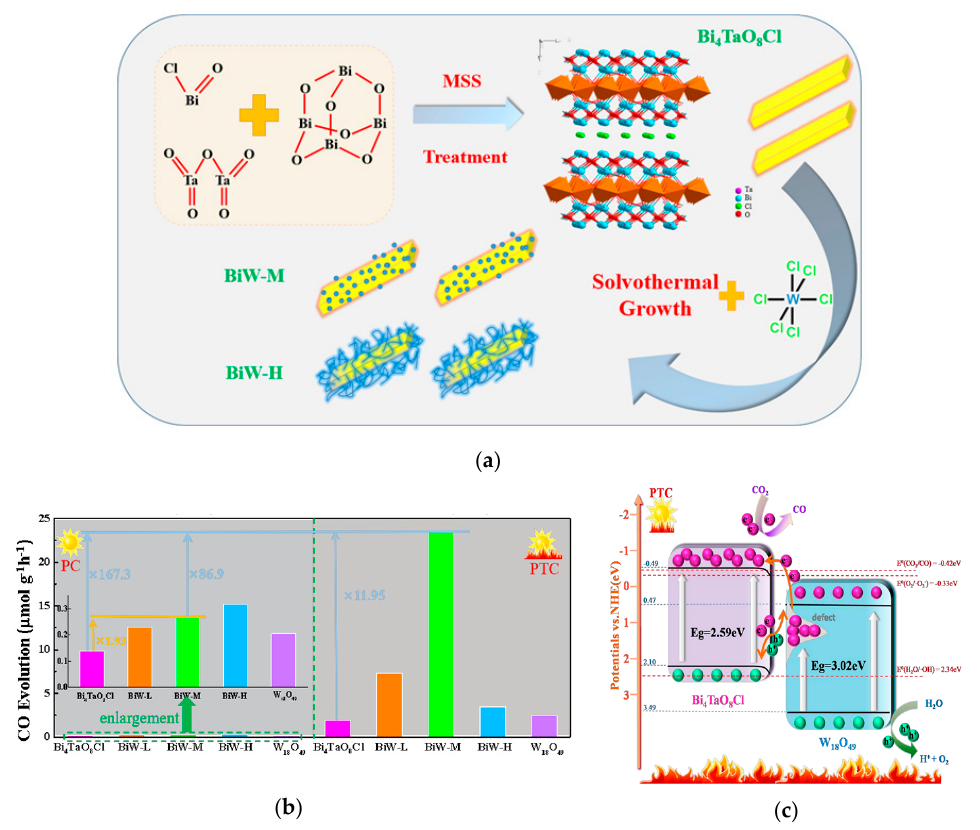
Figure 7. ( a ) The preparation process diagram of Bi 4 TaO 8 Cl/W 18 O 49 heterojunction;( b ) the amount of CO generated over different samples in the process of CO 2 reduction under photocatalysis (PC, 298 K) and photothermocatalysis (PTC, 393 K); BiW-L, BiW-M, BiW-H mean the samples synthesized by adding the low, middle, and high content of WCl 6 in the synthesis solution, respectively. ( c ) photothermal catalysis schematic diagram of Bi 4 TaO 8 Cl/W 18 O 49 heterojunction. Reproduced with permission from [120]. Copyright Elsevier, 2020.